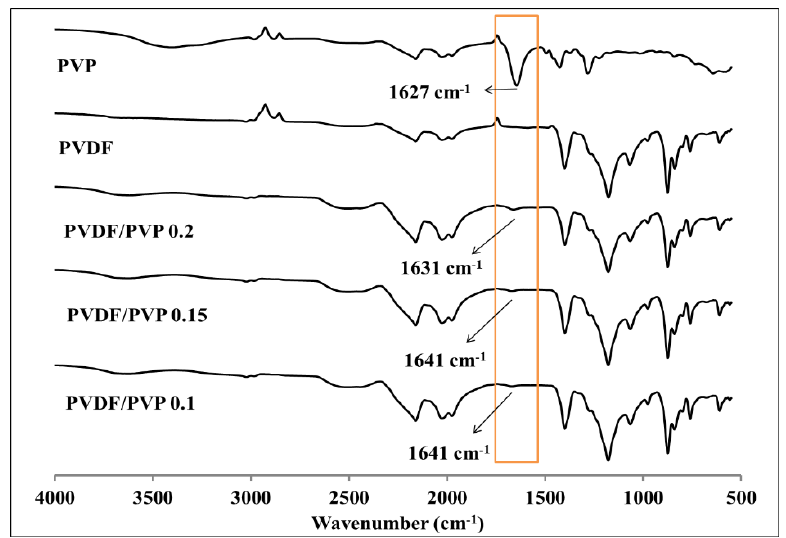
Figure 2. FTIR spectra of PVP, PVDF membranes, and PVDF membranes with various additions of PVP.